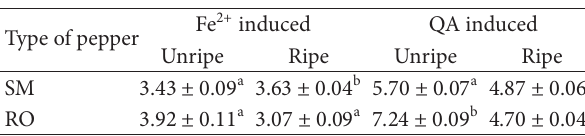
Table 2: EC values for inhibition of Fe 2+ and quinolinic acid 50 induced lipid peroxidation by Capsicum spp. (mg/mL).